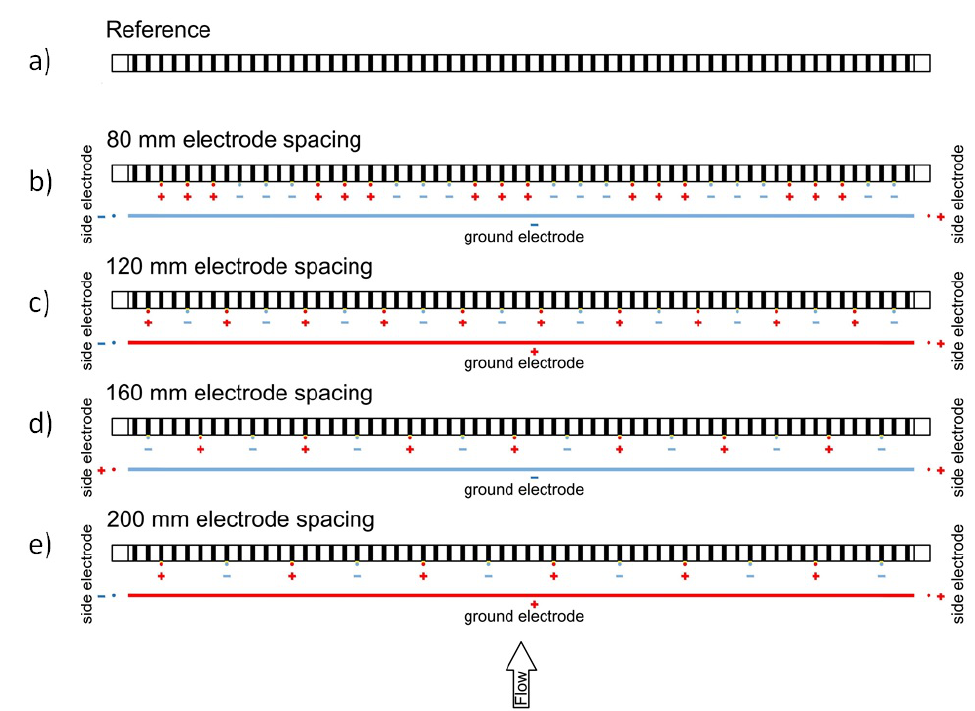
Figure 2. Location and polarization of the electrodes attached to the bar rack and additional electrodes at flume walls and channel bed for reference and electrified setups in layout view, flow from bottom to top. ( a ) s e = Reference, ( b ) s e = 80 mm, ( c ) s e = 120 mm, ( d ) s e = 160 mm, ( e ) s e = 200 mm electrode